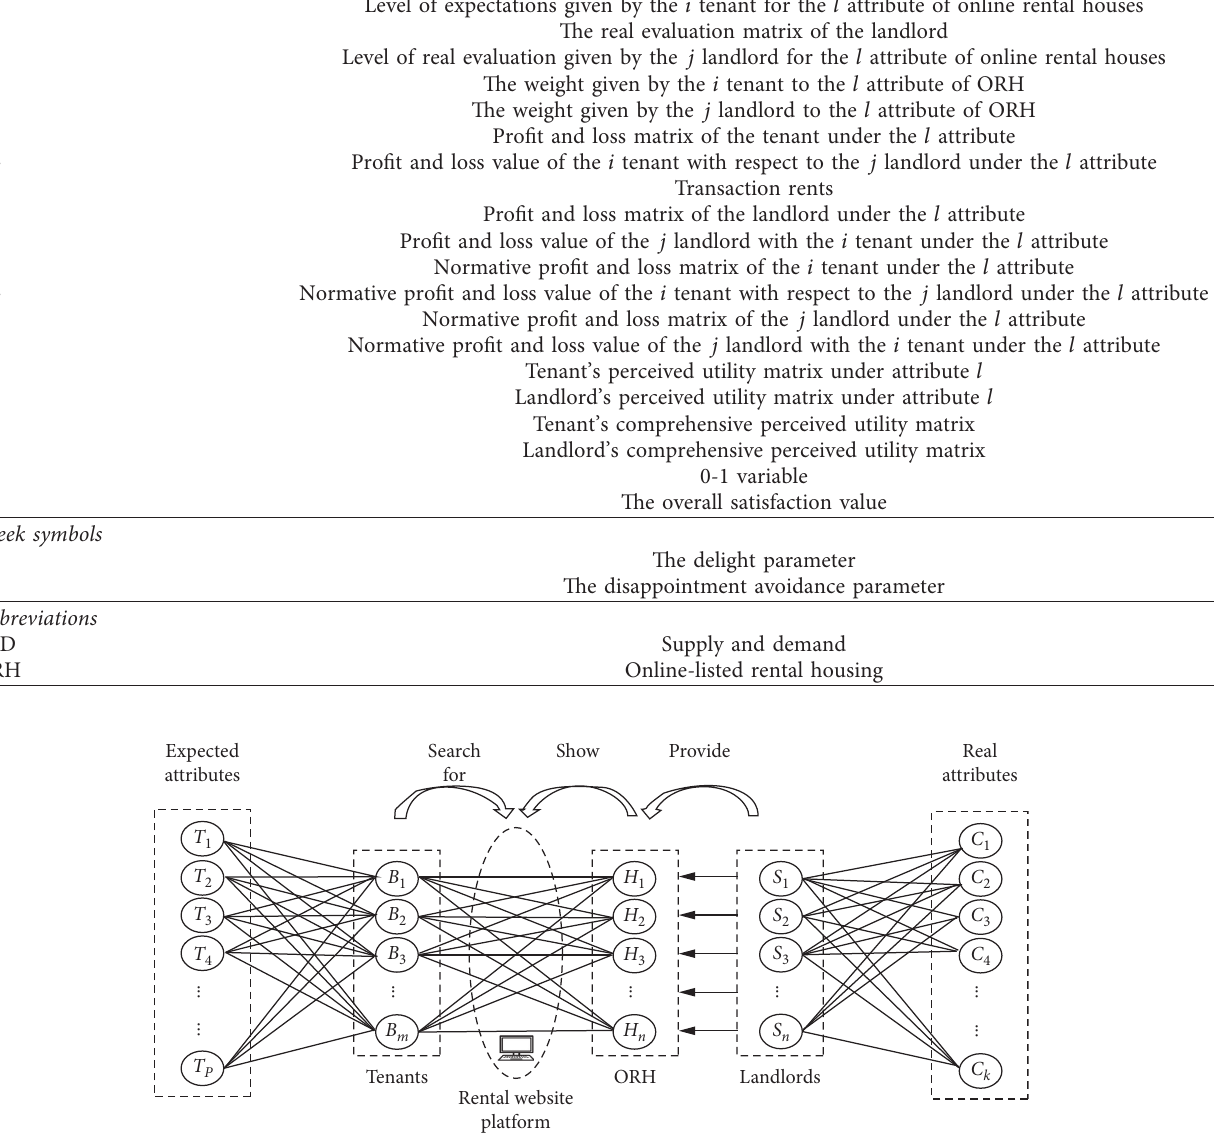
Figure 1: Multiattribute SAD matching decision model for the ORH matching